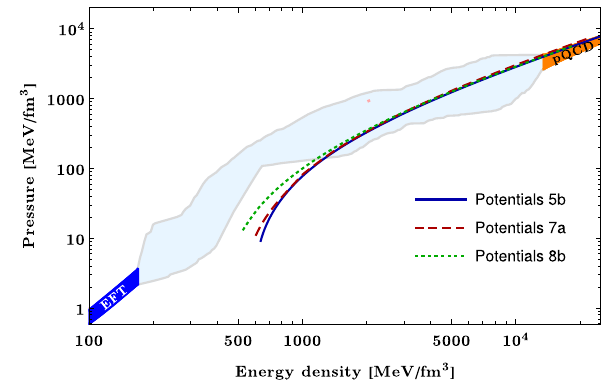
Fig. 11 The quark matter EOS from the V-QCD model for a selection of potentials compared to the band of allowed EOSs from polytropic